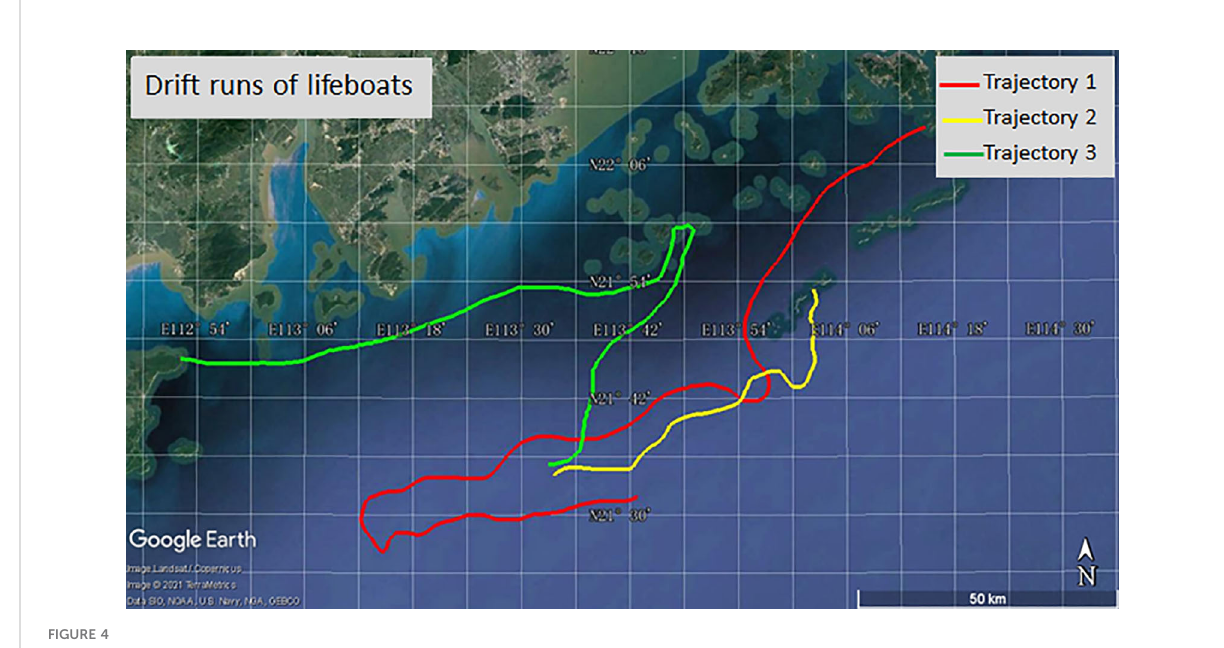
FIGURE 4 Drift trajectories and experimental